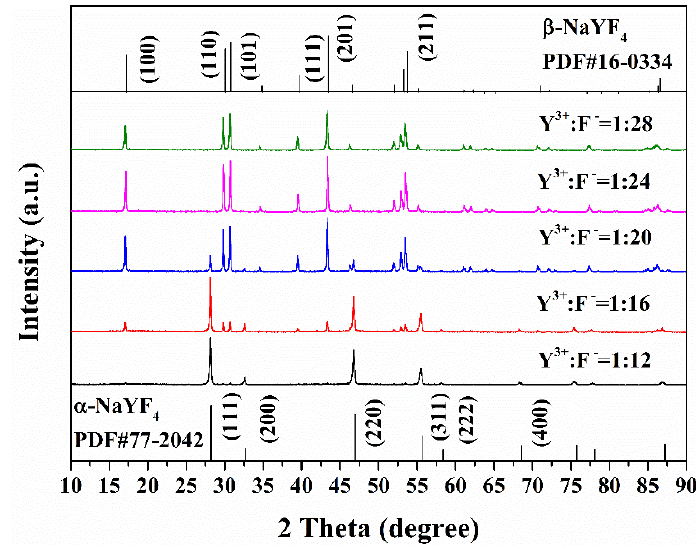
Figure 1. XRD patterns of NaYF 4 prepared with di ff erent Y 3 + :F − molar ratios in the reaction solution.